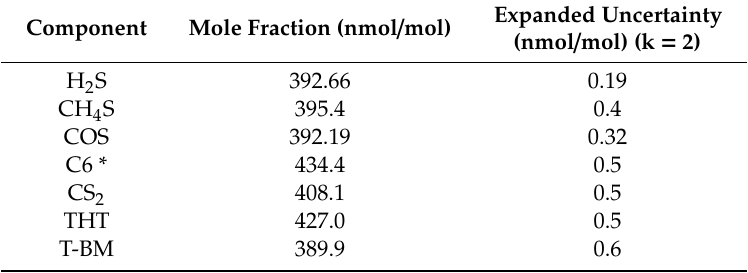
Table 3. Composition sulphur gas mixture